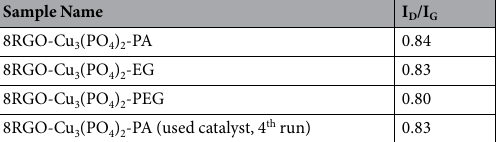
Table 1. Intensity ratio of (I D /I G ) in the copper phosphate